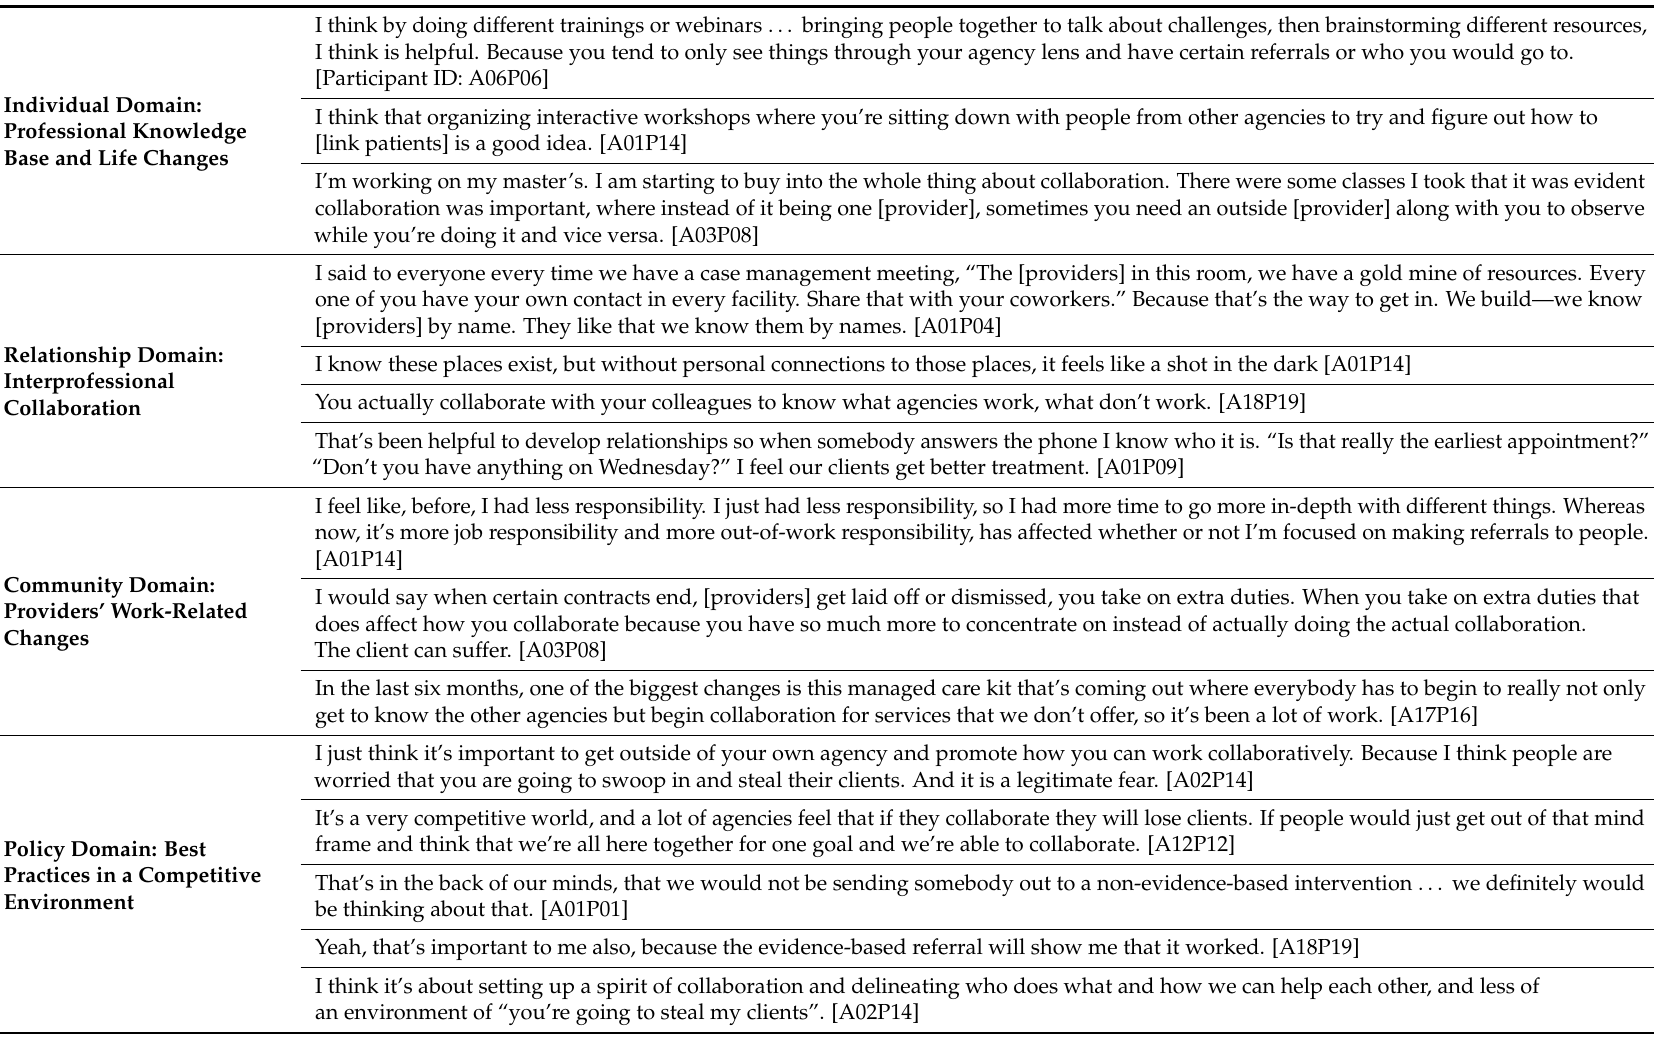
Table 1. Factors that influence providers’ linkage-making to care continuum